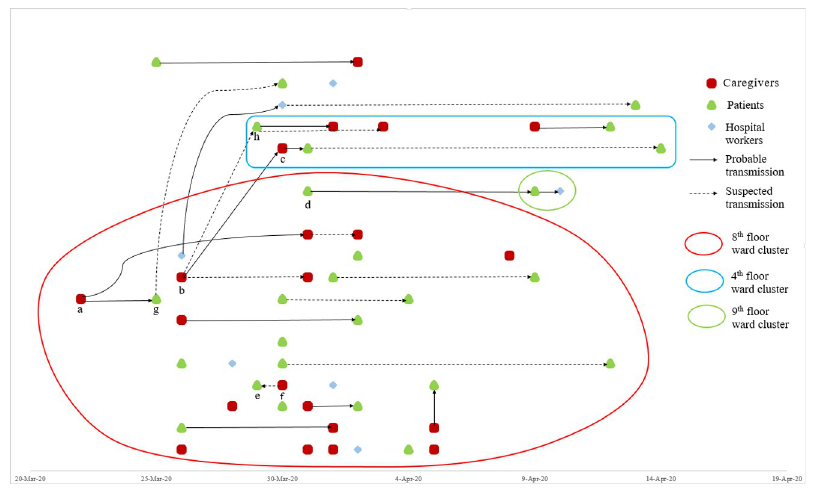
Fig 1. Transmission